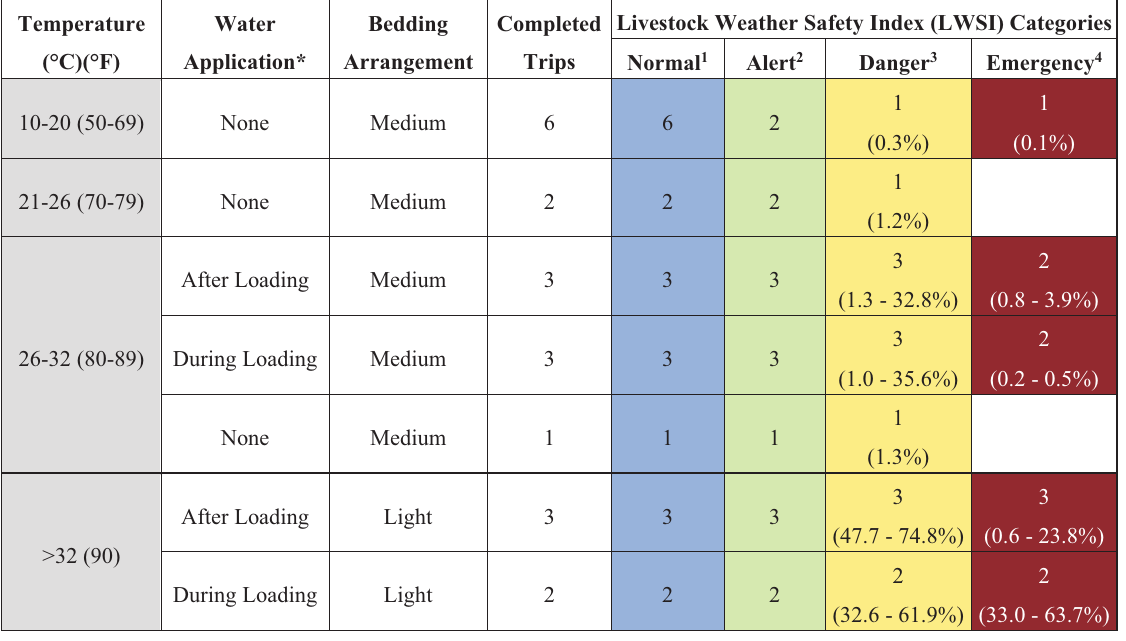
Table 6. Assessment of trailer environment based on categorizing all pig-level air temperature and zone-centered environmental measurements and their locations into LWSI categories for all transport durations when pigs were on the trailer. Data included 20 monitoring trips during temperatures above 10 °C. A colored block indicates that the condition occurred at some point during one of the trips monitored. The top number inside the colored block indicates the number of trips experiencing this condition. A single trip may experience multiple ranges of thermal comfort. The bottom number of the last two columns represents the percentage of the duration for that condition, with the range covering all trips for the given arrangement. THI, Temperature-Humidity